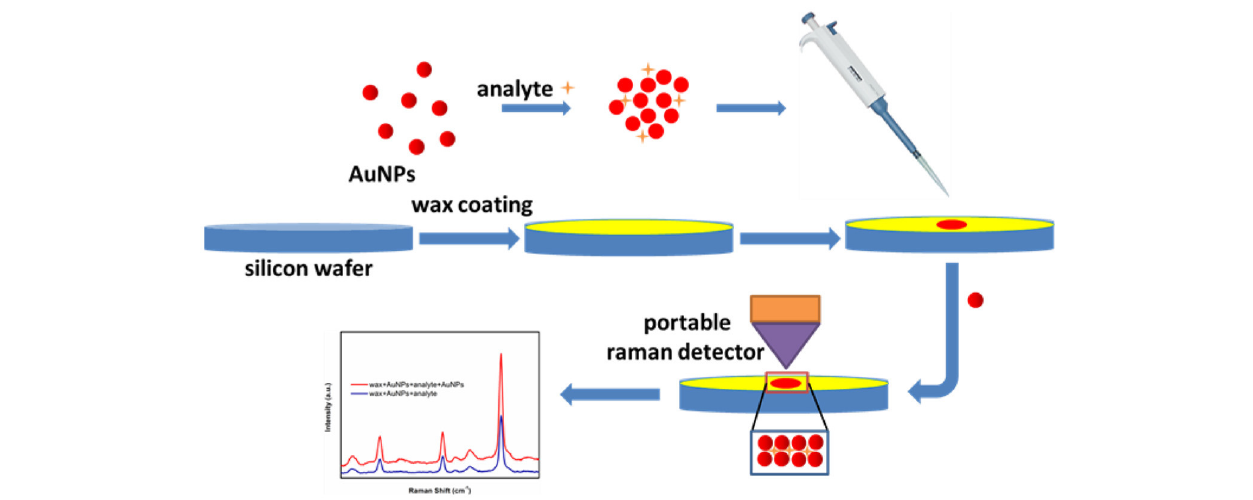
FIGURE 2 | Schematic of the SERS-based trace sensing platform enabled by AuNPs-analyte/AuNPs double-decker structure on wax-coated hydrophobic surface.